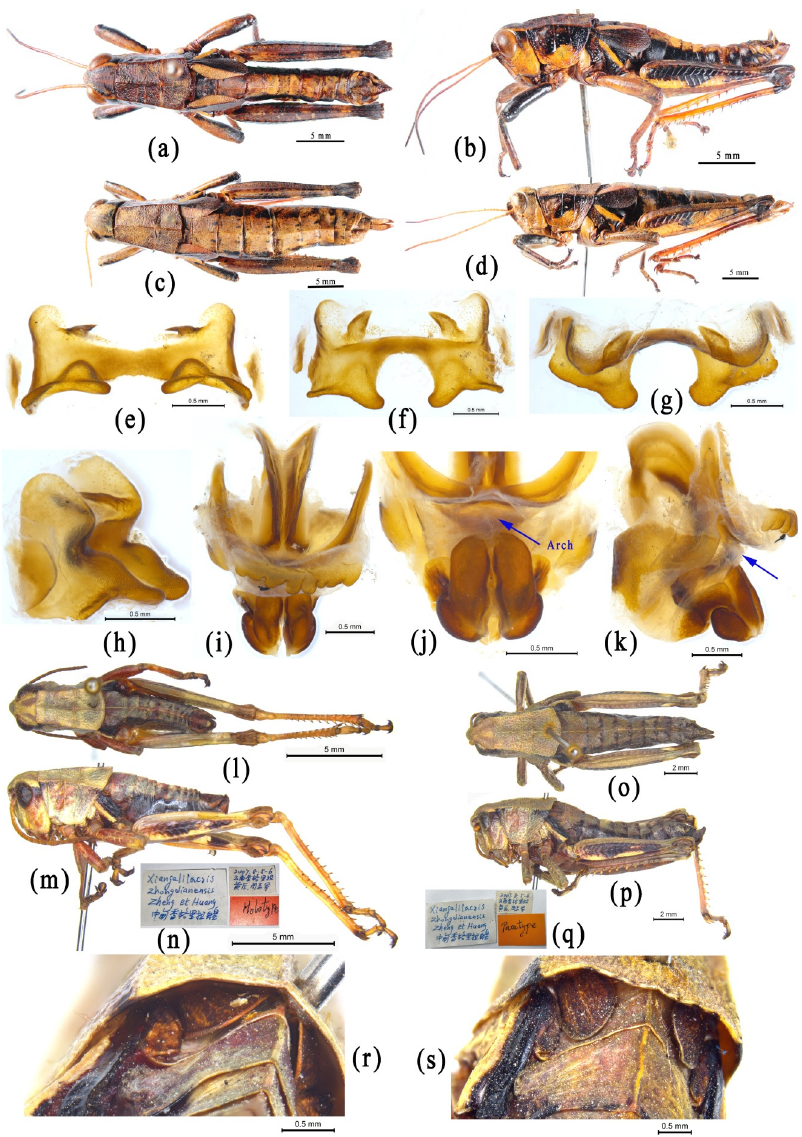
Figure 7. Morphological characters of Conophymacris szechwanensis and Xiangelilacris zhongdianensis . ( a – k ) Conophymacris szechwanensis . ( a , b ) Male habitus. ( c , d ) Female habitus. ( e – h ) Epiphallus in dor- sal, dorsofrontal, frontal and dorsolateral lateral views. ( i – k ) Phallic complex in dorsal and lateral views. ( l – s ) Types of Xiangelilacris zhongdianensis . ( l , m ) Holotype male habitus. ( n ) Labels of the holotype male (the chinese character sting below the scientific name Xiangelilacris zhongdianensis in